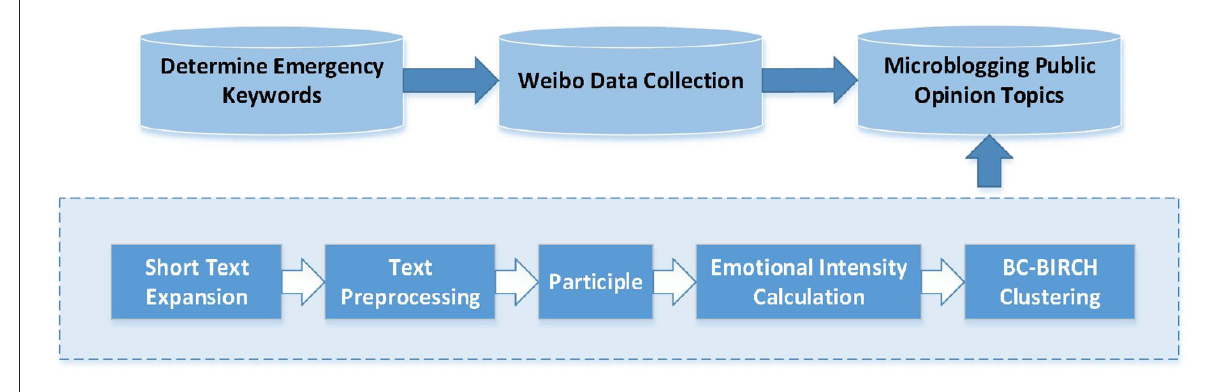
FIGURE3 The structure of the topic clustering model for public